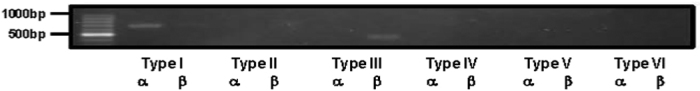
Type I Nrg1α is predominantly expressed in normal liver.The expression pattern of Nrg1 isoforms was analysed by PCR. Note that two distinct types of Nrg1 transcripts, Type I Nrg1α and Type III Nrg1β, were detected in normal liver.